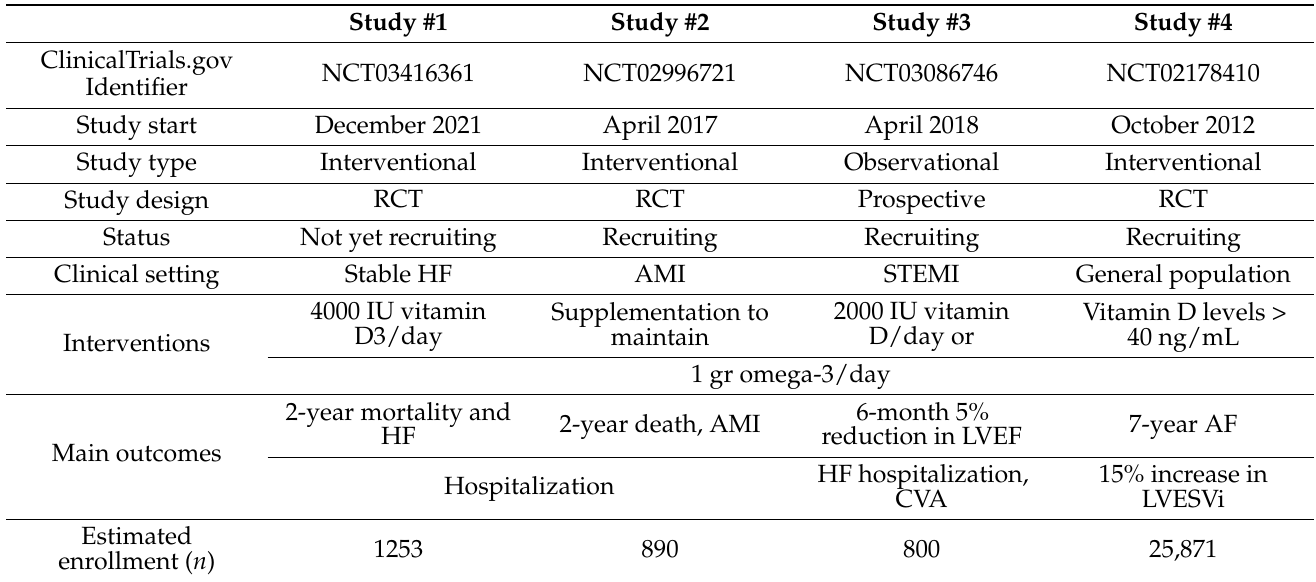
Table 2. Main current studies (recruiting or not yet recruiting) focusing on vitamin D clinical relevance or supplementation in patients with cardiovascular disease (ClinicalTrials.gov data, updated to 23 September